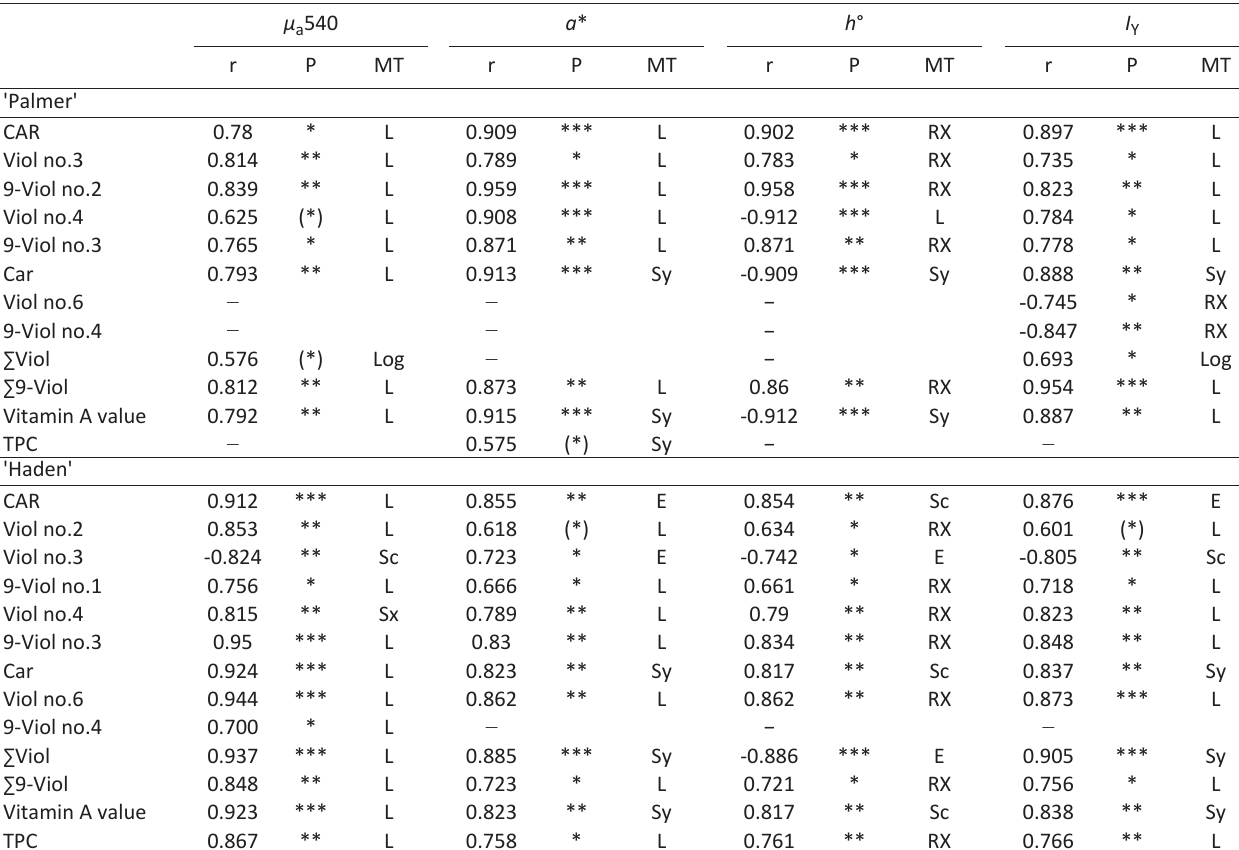
Table 7 - Results of regression analysis between absorption coefficient at 540 nm ( μ a 540), pulp color parameters and total carotenoid (CAR), total phenolic compounds (TPC), carotenoid compounds (for identification data see Table 1) and vitamin A